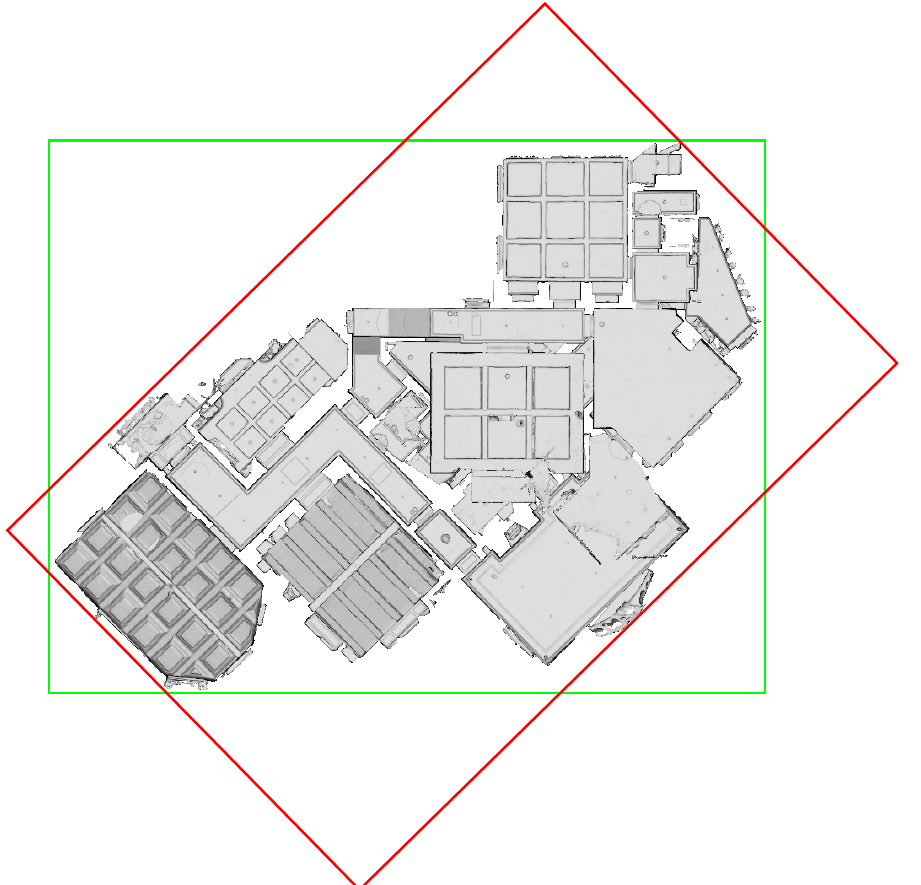
Figure 23. The green bounding box represents the horizontal alignment of the triangle mesh “UL- sKaCPVFJR” from Figure 15i as it is published in [90] and used as the ground truth pose for the evaluation results presented in Table 1. The red bounding box, on the other hand, represents the horizontal alignment resulting from our presented